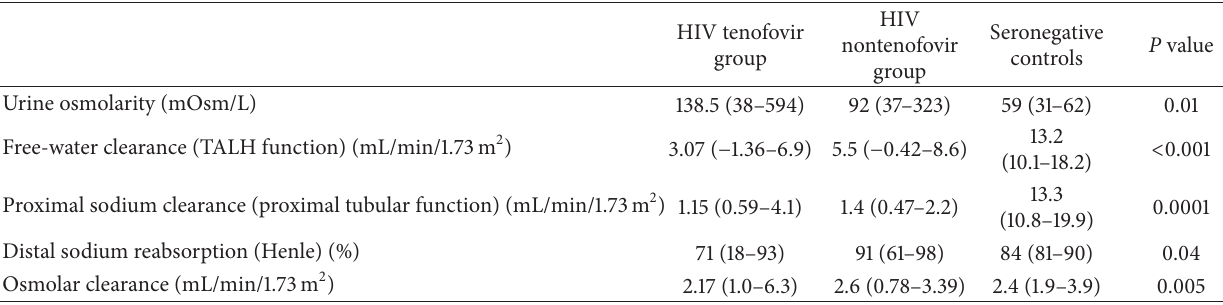
Table 4: Chaimowitz’ test specific results. Comparison between HIV groups and seronegative controls: median (range)